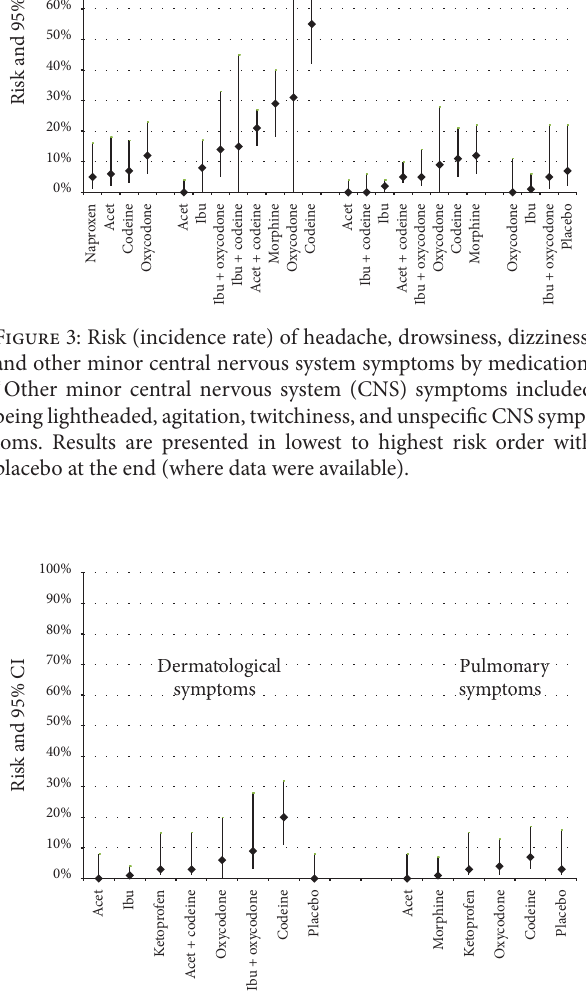
Figure 4: Risk (incidence rate) of dermatological and pulmonary symptoms by medication. ∗ Dermatological symptoms included itchiness, rash, and pruritus. Results are presented in lowest to highest risk order with placebo at the end (where data were